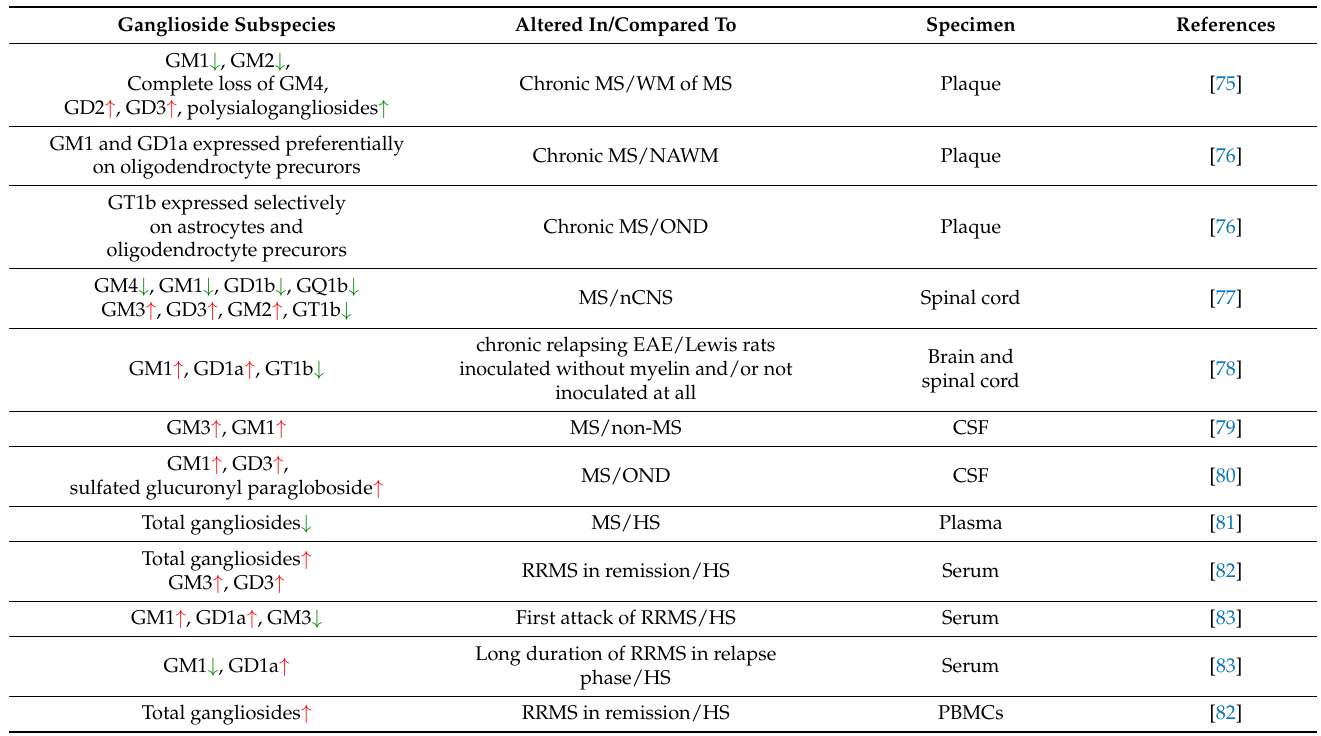
The alterations are shown as colored arrows: increase in red and decrease in green. Abbreviations: CSF— cerebrospinal fluid, HS—healthy subjects, MS—multiple sclerosis, NAWM—normal appearing white